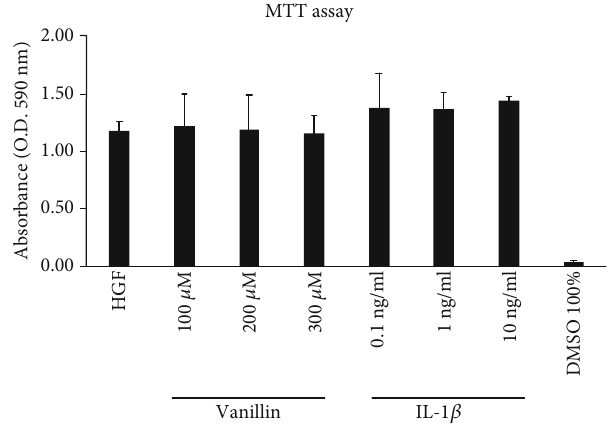
Figure 1: MTT viability assay in HGF cell treated for 24h with Vanillin (100, 200, and 300 μ M) or IL-1 β (0.1, 1, and 10 ng/ml). Absorbance values are given as media ± SD of three independent